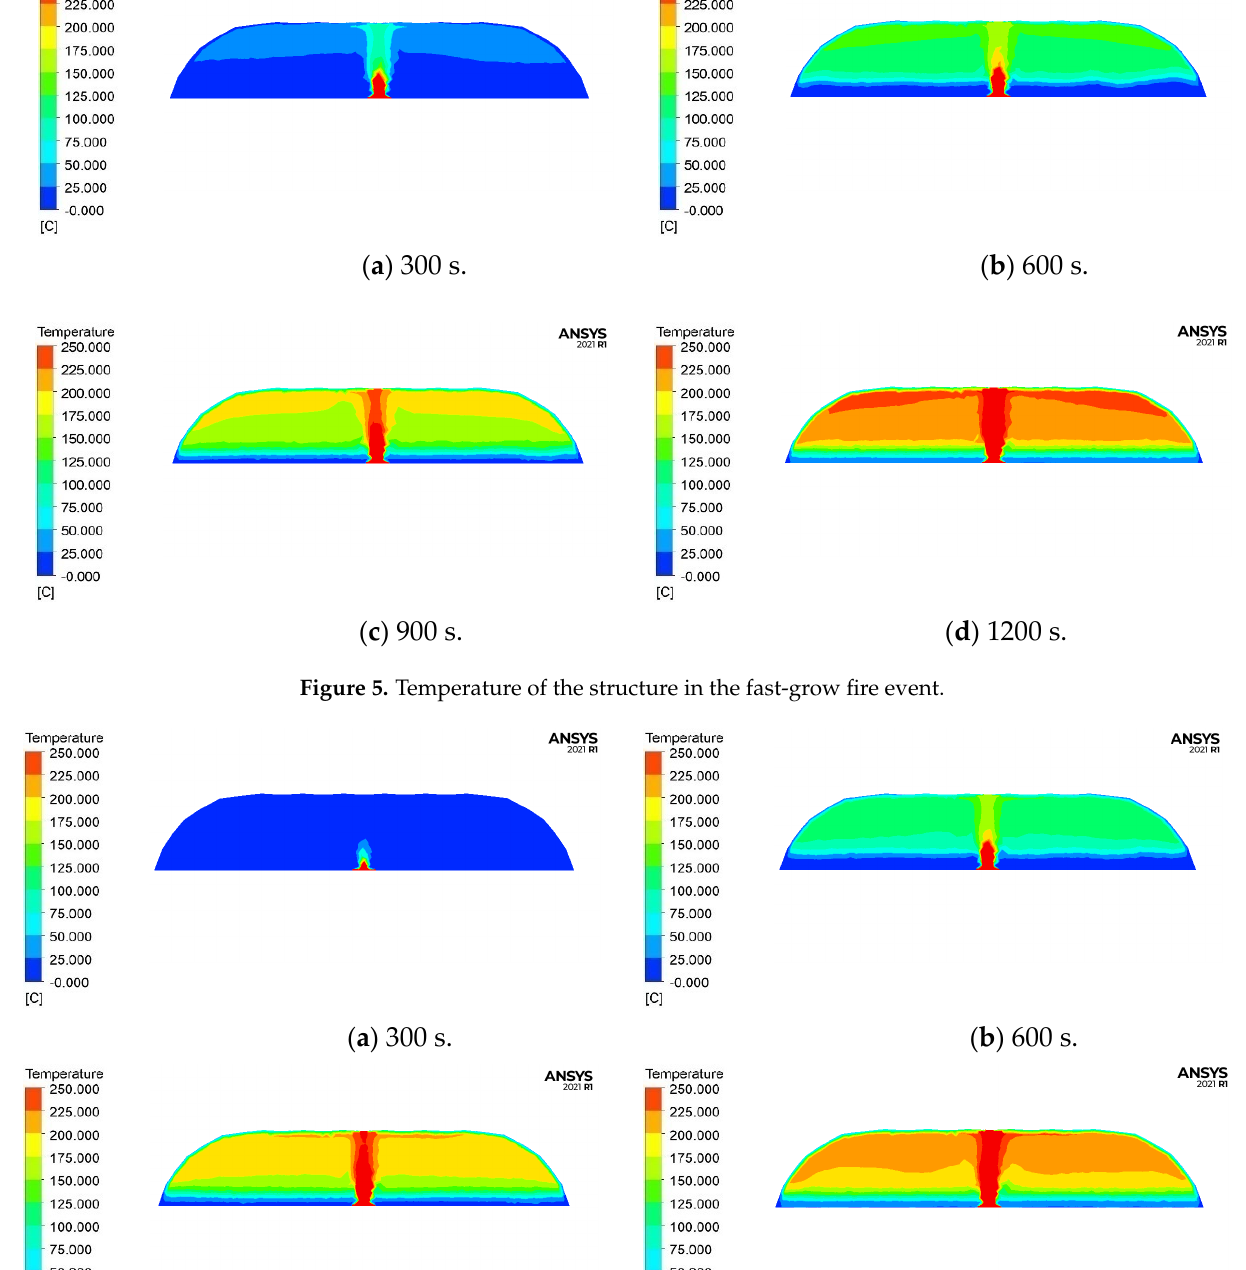
Figure 4. Temperature of the structure in the very-fast-grow fire event.